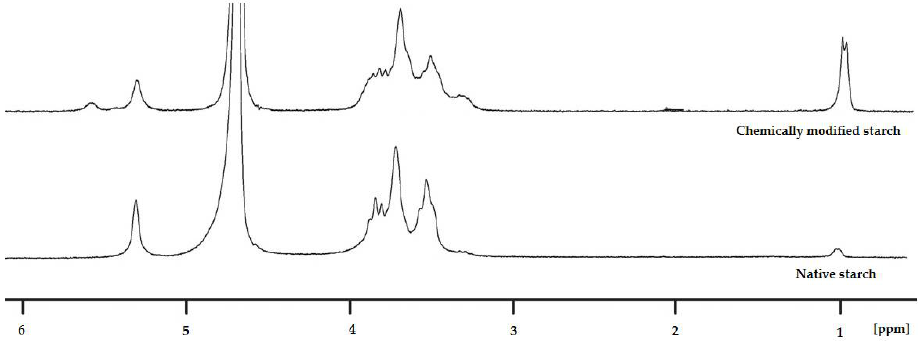
Figure 1. 1 H NMR spectra of native starch and chemically modified starch.